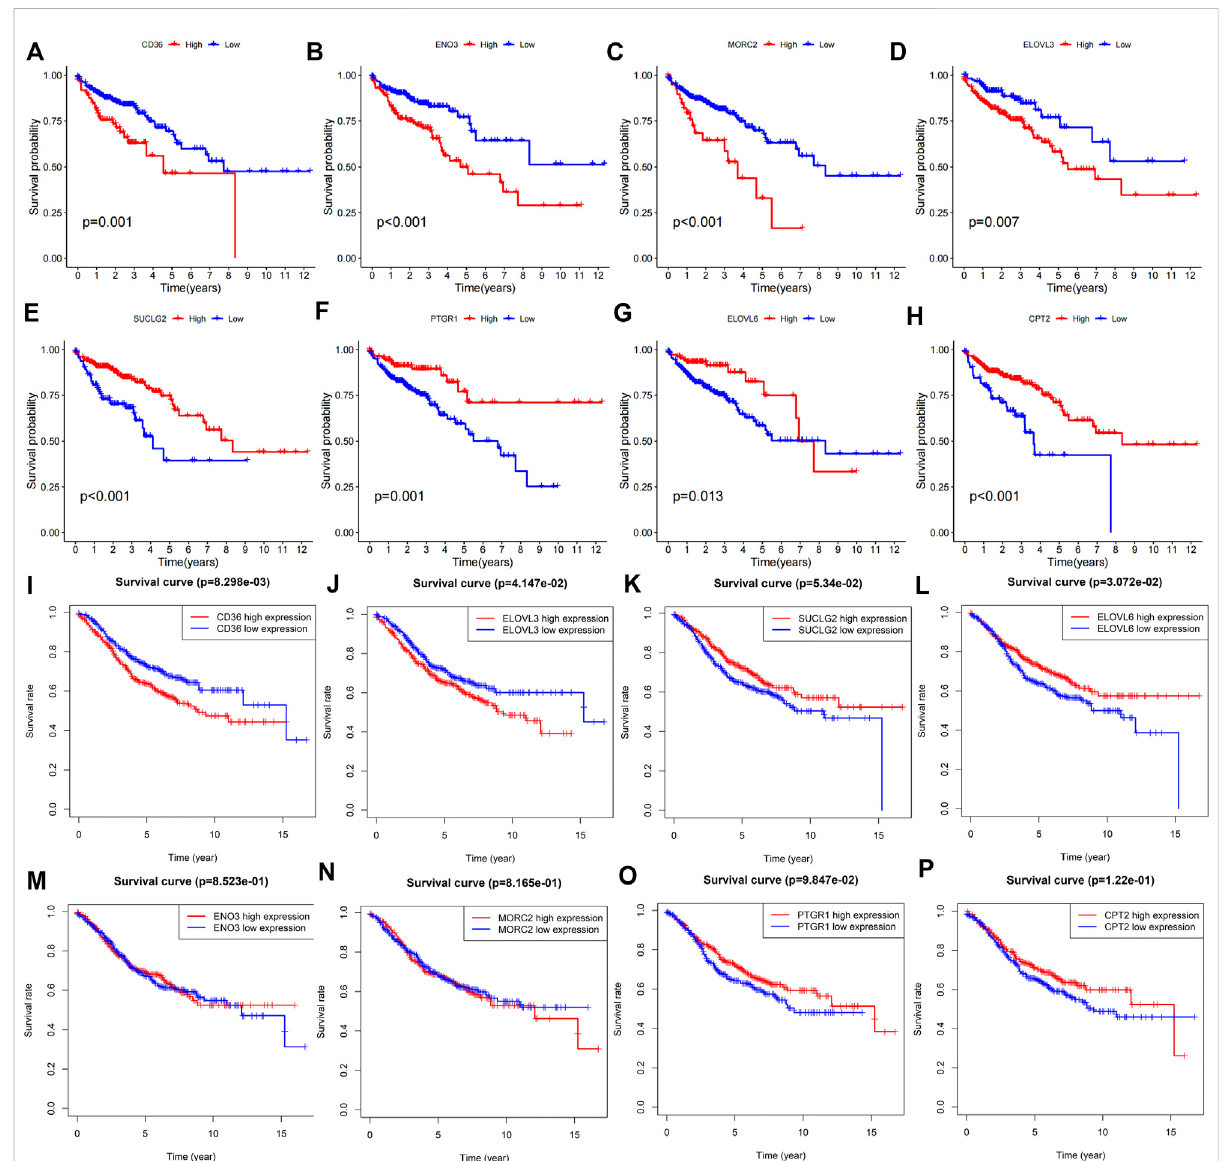
FIGURE 10 Prognostic roles of the risk FAM-related genes in COAD. Kaplan-Meier survival analyses were utilized to study the predictive roles of (A) CD36, (B) ENO3, (C) MORC2, (D) ELOVL3, (E) SUCLG2, (F) PTGR1, (G) ELOVL6 and (H) CPT2 according to TCGA-COAD cohort. GEO dataset validated the prognostic values of (I) CD36, (J) ELOVL3, (K) ELOVL6, (L) SUCLG2, (M) ENO3, (N) MORC2, (O) PTGR1 and (P) CPT2 in colon